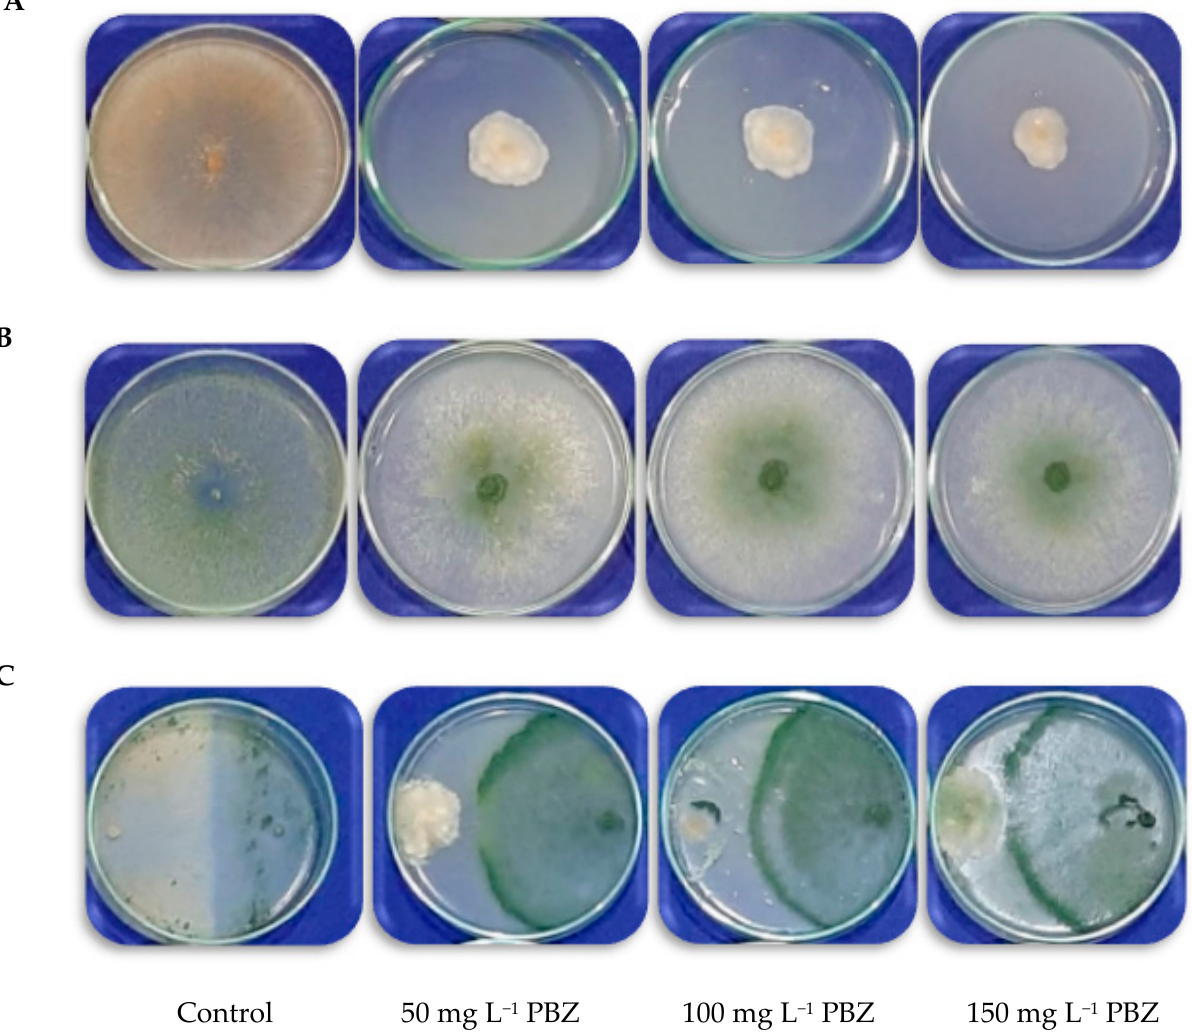
Figure 5. Different effects of PBZ concentrations on both of R. solani pathogen and T. harzianum bioagent as well as improves antagonistic effects of T. harzianum against R. solani . ( A ) R. solani + PBZ, ( B ) T. harzianum + PBZ, and ( C ) T. harzianum + PBZ and R. solani . Table 5. In vitro antagonistic effect (inhibition) of Trichoderma harzianum against Rhizoctonia solani on PDA treated with PBZ applications .